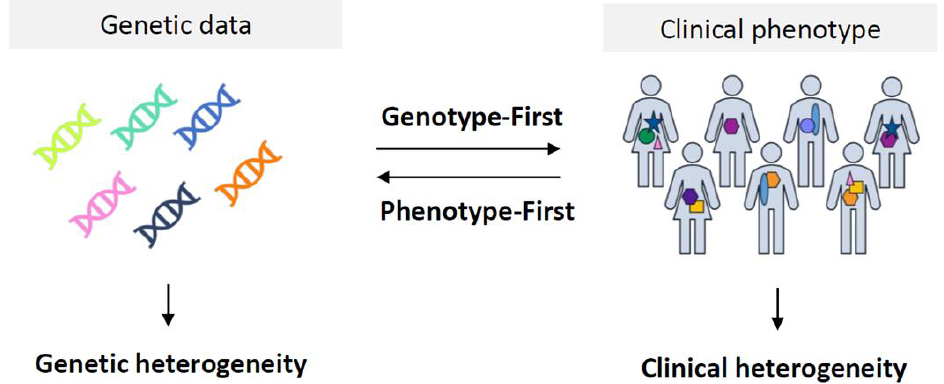
Figure 2. Graphical representation of the various concepts in the field of medical genetics. Genetic heterogeneity refers to the concept that pathogenic variants in multiple genes may lead to the same phenotypic presentation, whereas clinical heterogeneity refers to the fact that pathogenic variants in the same gene may lead to different clinical representations. A genotype-first approach starts from the genetic data point of view: after the identification of a pathogenic variant, the phenotype is thoroughly examined. In a phenotype-first approach, the clinical presentation of the patient with ID is obtained first, which is subsequently used as a guide for (targeted) genetic testing.